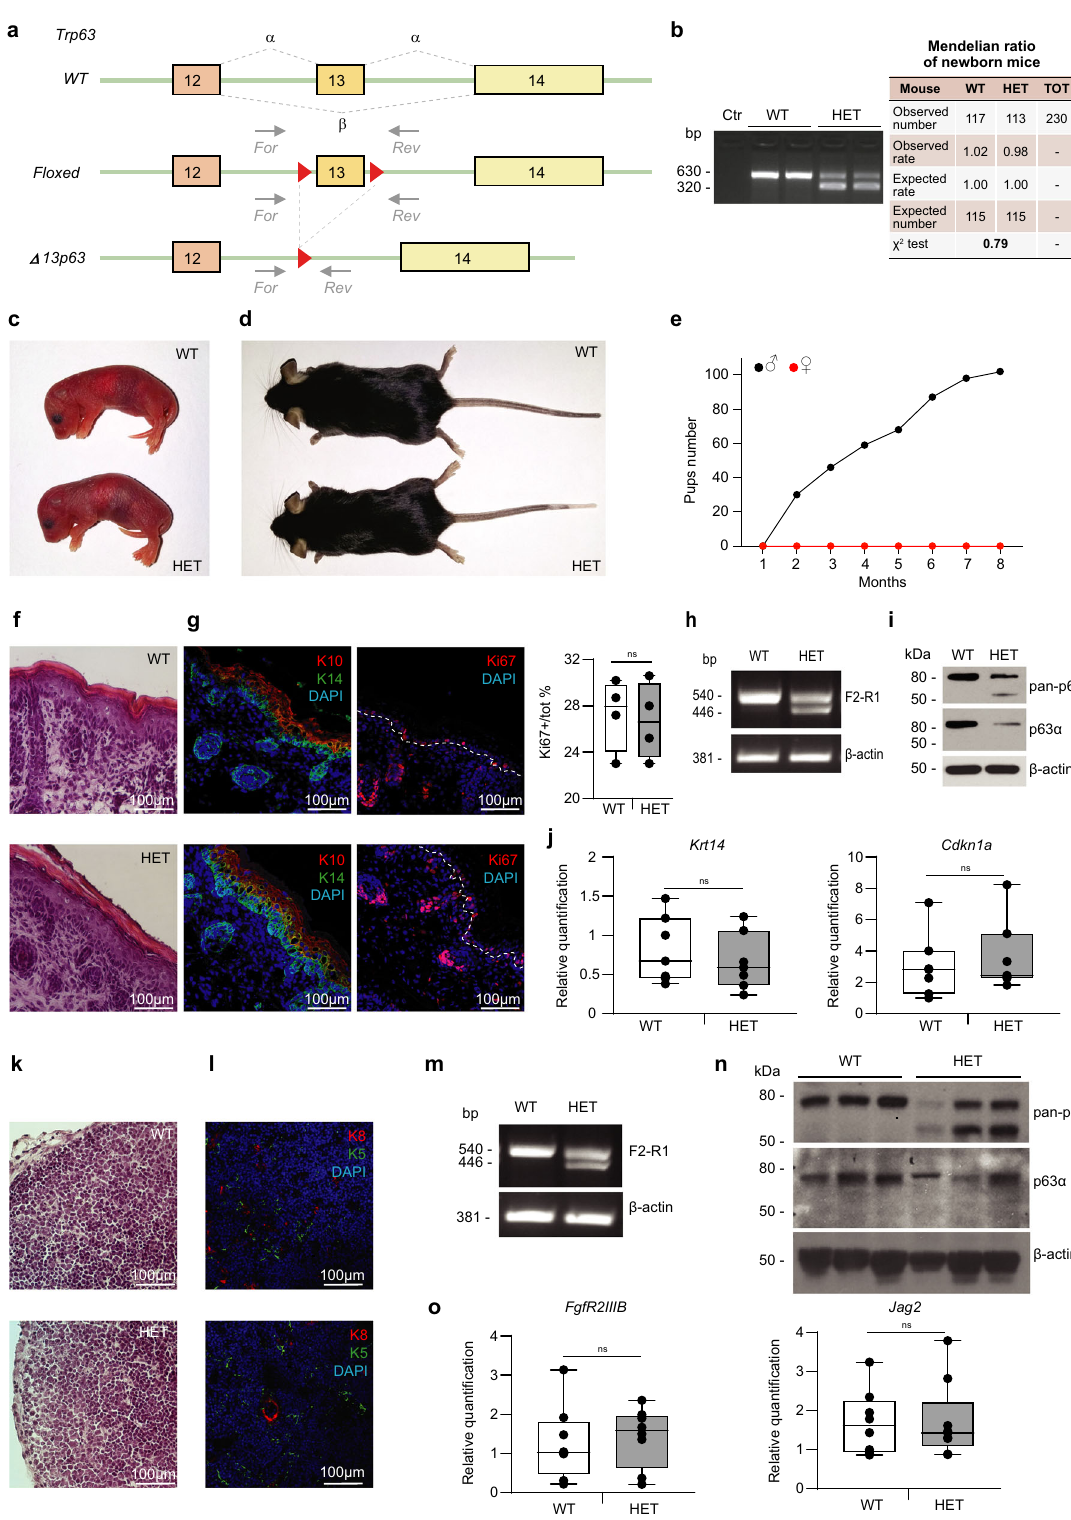
p63 γ isoform was unaltered in both WT and p63 HET Δ 13p63 animals (primers F4-R2, Supplementary Fig. 1d). Sequencing